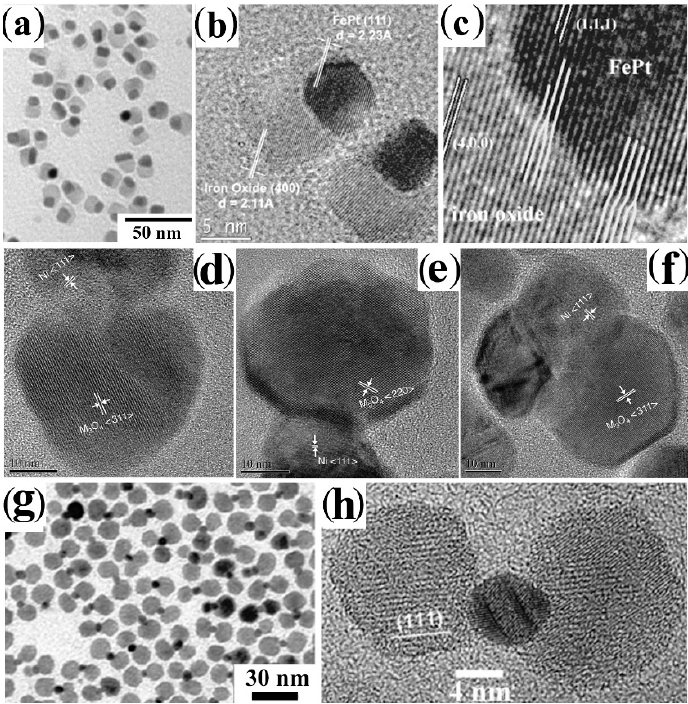
Figure 9. Gallery of representative heteromeric CNHSs formed by mechanisms that do not involve direct heterogeneous nucleation-growth over preformed seeds. ( a ) Low-magnification TEM and ( b , c ) HRTEM images of FePt–Fe 3 O 4 hetero-dimer CNHSs formed upon self-controlled nucleation- growth (cf. Scheme 3c) (reproduced with permission from Ref. [297], Copyright 2008, American Chemical Society). ( d – f ) HRTEM images of FeNi-Me x O y hetero-dimer CNHSs, derived by solid- state diffusion/phase segregation (cf. Scheme 3d) (reproduced with permission from Ref. [299], Copyright 2015, Royal Society of Chemistry). ( g , h ) TEM and HRTEM images of Fe 3 O 4 –Au–Fe 3 O 4 hetero-trimer CNHSs with a Au domain connecting two Fe 3 O 4 domains, derived from induced welding of preformed Au–Fe 3 O 4 hetero-dimer seeds (cf. Scheme 3e) (reproduced with permission from Ref. [99], Copyright 2006, American Chemical